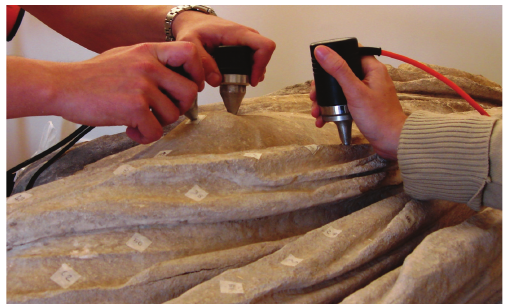
Figure 2: One transmitter and two ultrasonic receivers on the statue of Togato di Petrara (2nd century A.D.) [31].